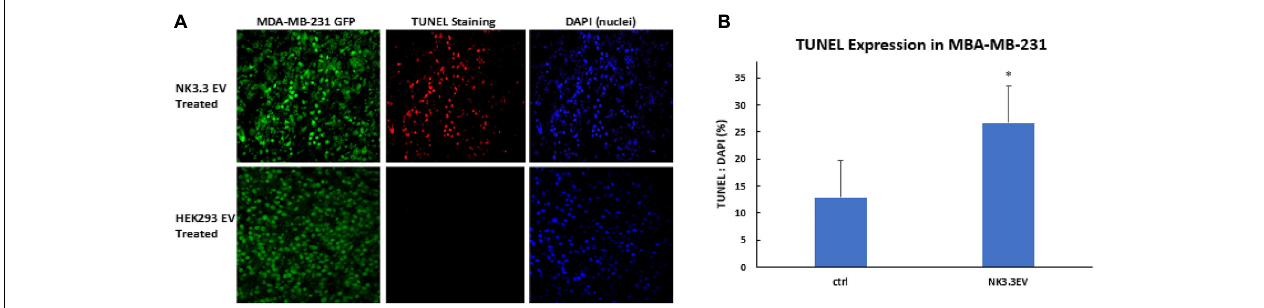
FIGURE 9 | Apoptosis induction in MDA-MB-231 breast cancer cells by intratumoral injection of NK3.3 EVs in vivo . (A) GFP-expressing MDA-MB-231 tumors in the mammary fat pad of female nude mice were excised, paraffin embedded, sectioned, and subjected to TUNEL staining (red). Tumor cells: GFP+ (green); Nuclei: DAPI+ (blue). EVs from HEK293 human epithelial cells served as a negative control. (B) Comparison of TUNEL staining of tumors from control and NK3.3 EV-treated mice. Whole slide scanning was performed, and fluorescence intensity was quantitated using CellSelect software. Results of tumor sections from 4 control and 5 NK3.3 EV-treated mice are presented as % TUNEL/DAPI positive. ∗ p < 0.05.